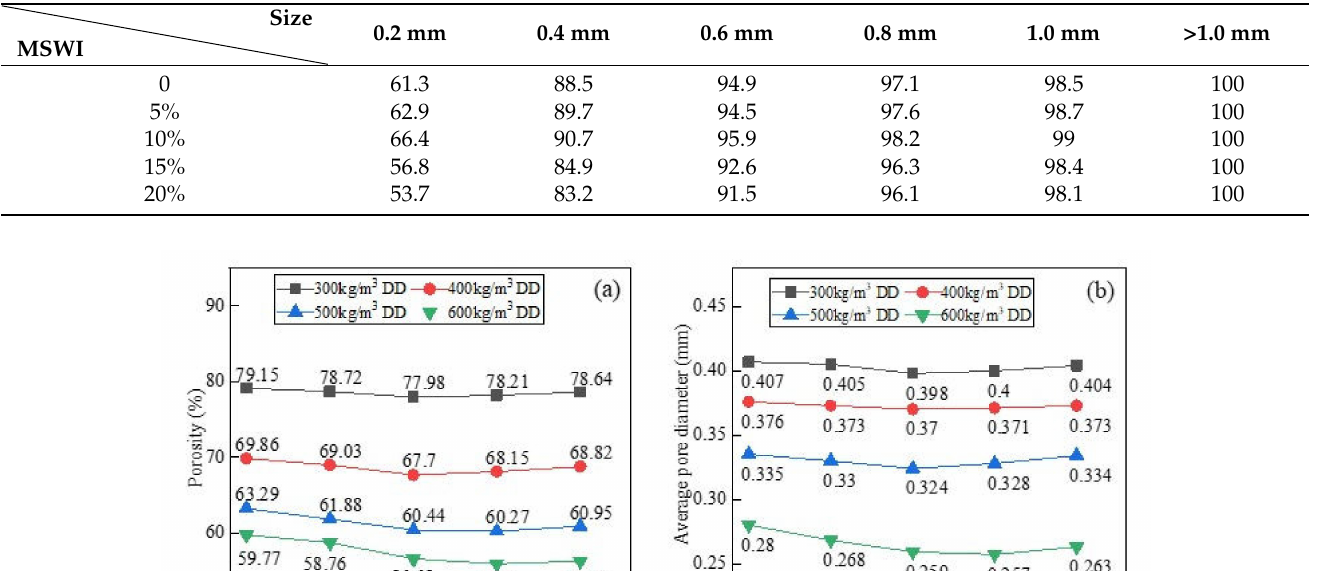
Table 6. Cumulative distribution of apertures with different dosages.